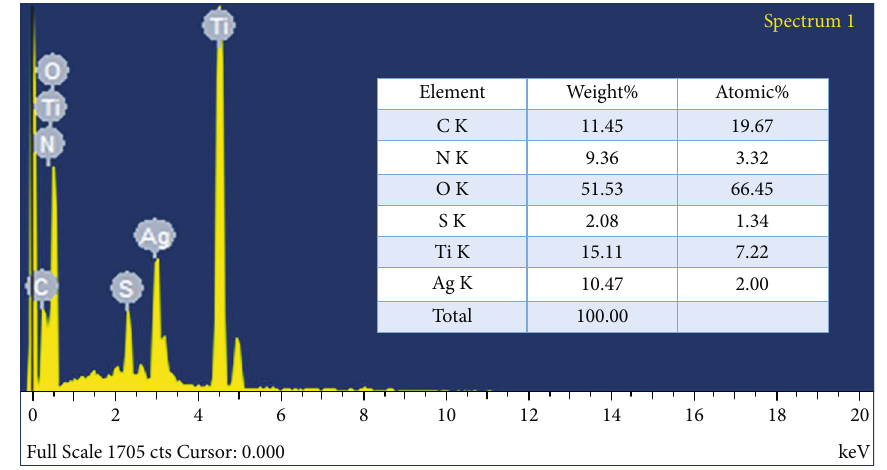
Figure 4: EDX analyses of the binary P3NT/30%AgTiO